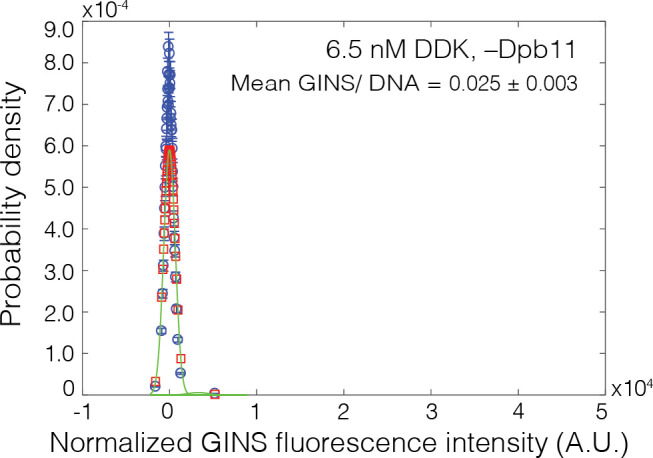
Dpb11 dependence of GINSSORT649 binding.GINSSORT649 fluorescence-intensity histograms (blue) on Mcm2-72SORT549-bound DNA in the absence of Dpb11. The histogram data were fit to a sum-of-Gaussians model (red; see Materials and methods). Fit parameters and calculated area fractions of individual Gaussian components (green) corresponding to the presence of the indicated numbers of GINSSORT649 molecules are given in Supplementary file 1b. The mean (± SE) number of GINS molecules per DNA are calculated from the fit parameters and the fraction GINS labeled.